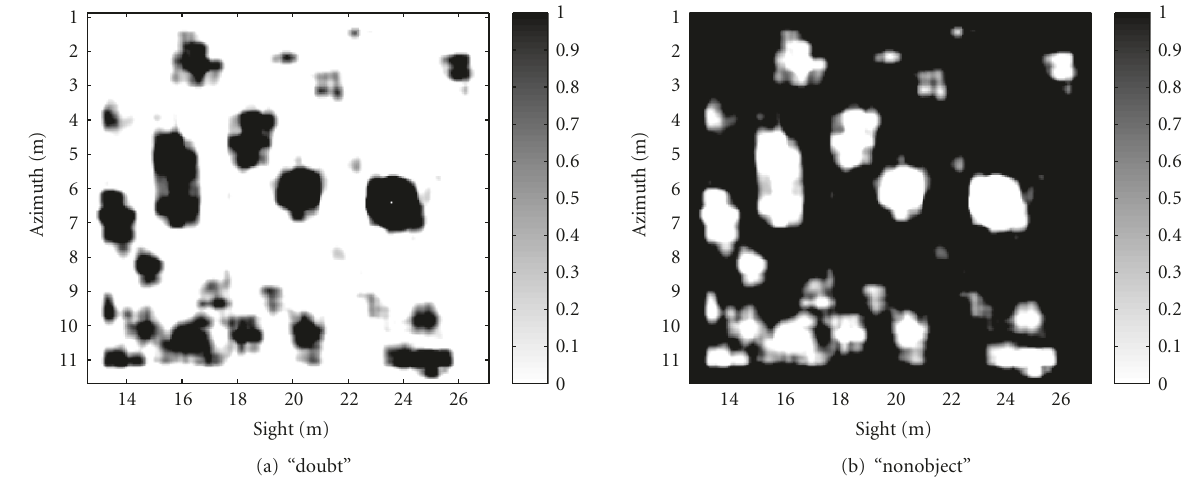
Figure 14: Mass images obtained for each proposition with the skewness parameter in image 1.